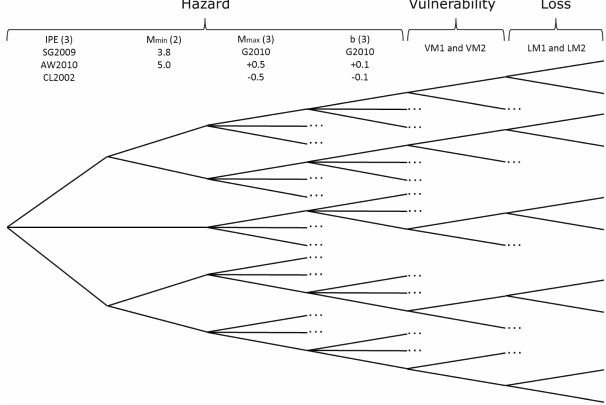
Figure 1. Logic tree scheme and number of input parameters for the different modules: Hazard: intensity prediction equations (IPEs) – 3, M min – 2, M max – 3, Gutenberg–Richter b – 3, Vulnerability: 2 models, Loss: 2 models. Equal weights are assigned to all the branches of the logic tree (more details in the text).